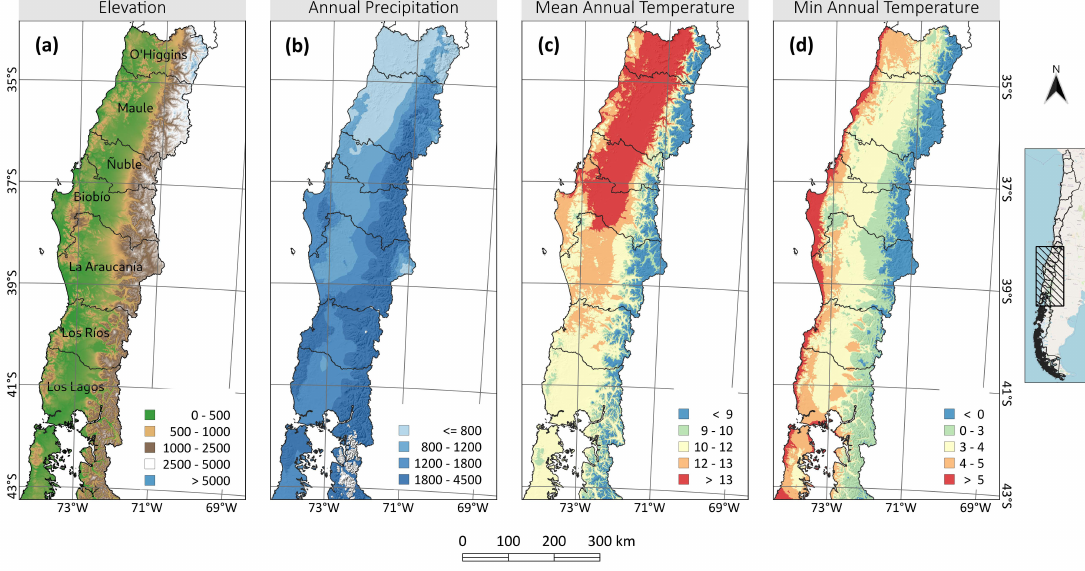
Figure 2. Topographic and climatic variability of study area. ( a ) elevation [m a.s.l.]; ( b ) annual precipitation [mm]; ( c ) mean annual temperature [ ◦ C]; and ( d ) minimum annual temperature [ ◦